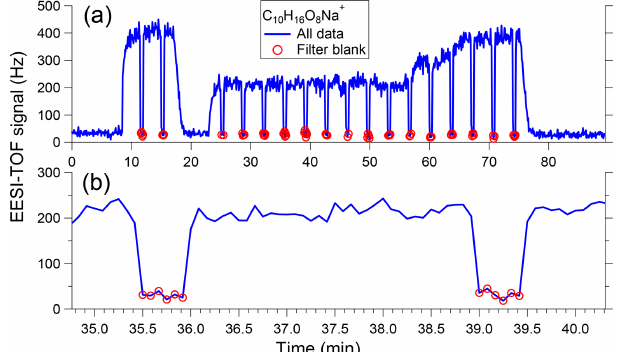
Figure 2. (a) Sample time series of [ C 10 H 16 O 8 ] Na + measured in SOA generated from α -pinene ozonolysis, showing aerosol mea- surement periods (3min) interspersed with filter blanks (30s). The difference between these two conditions yields the signal due to sampled particles. (b) Expanded view of two measurement–filter cycles showing instrument response to filter switching is ∼